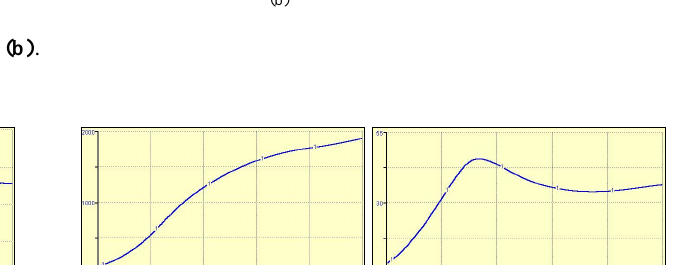
Fig. 20. Simulation results of the main ecological indexes at zone I